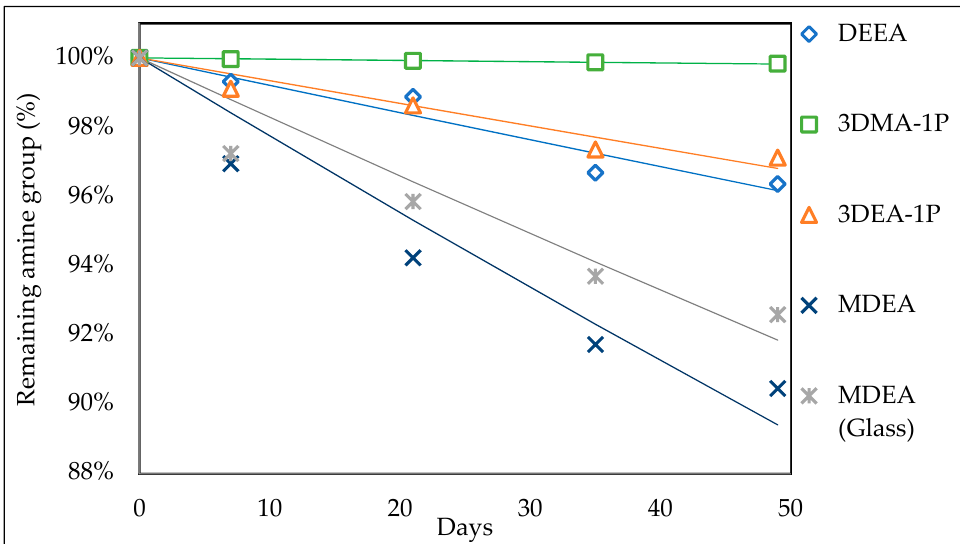
Figure 5. Remaining amine group concentration in amine monoethylene glycol (MEG) blends, with solid lines representing the model results; unloaded amine wt.% = 30; CO 2 loading ≈ 0.1.